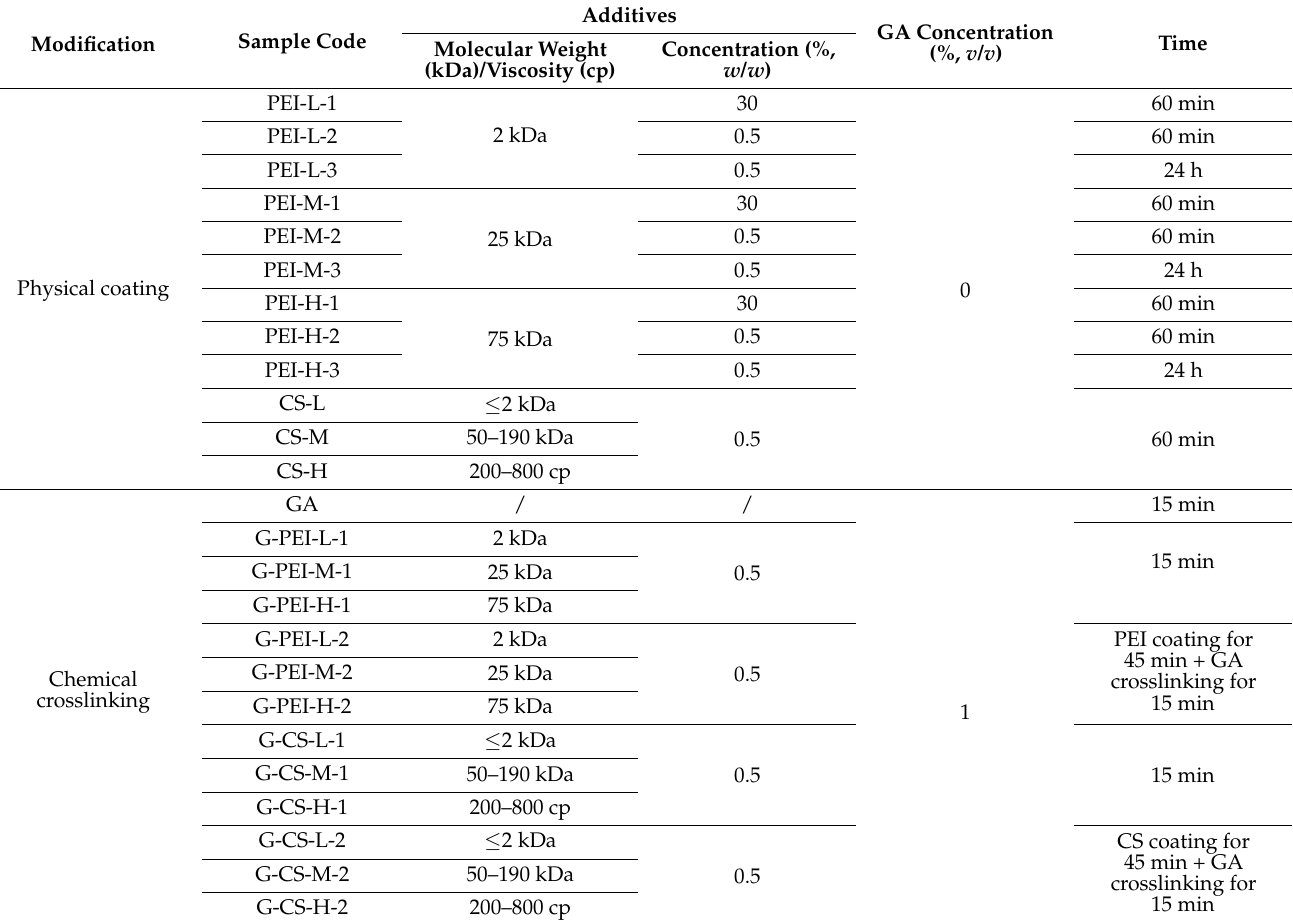
Table 2. Summary on modification